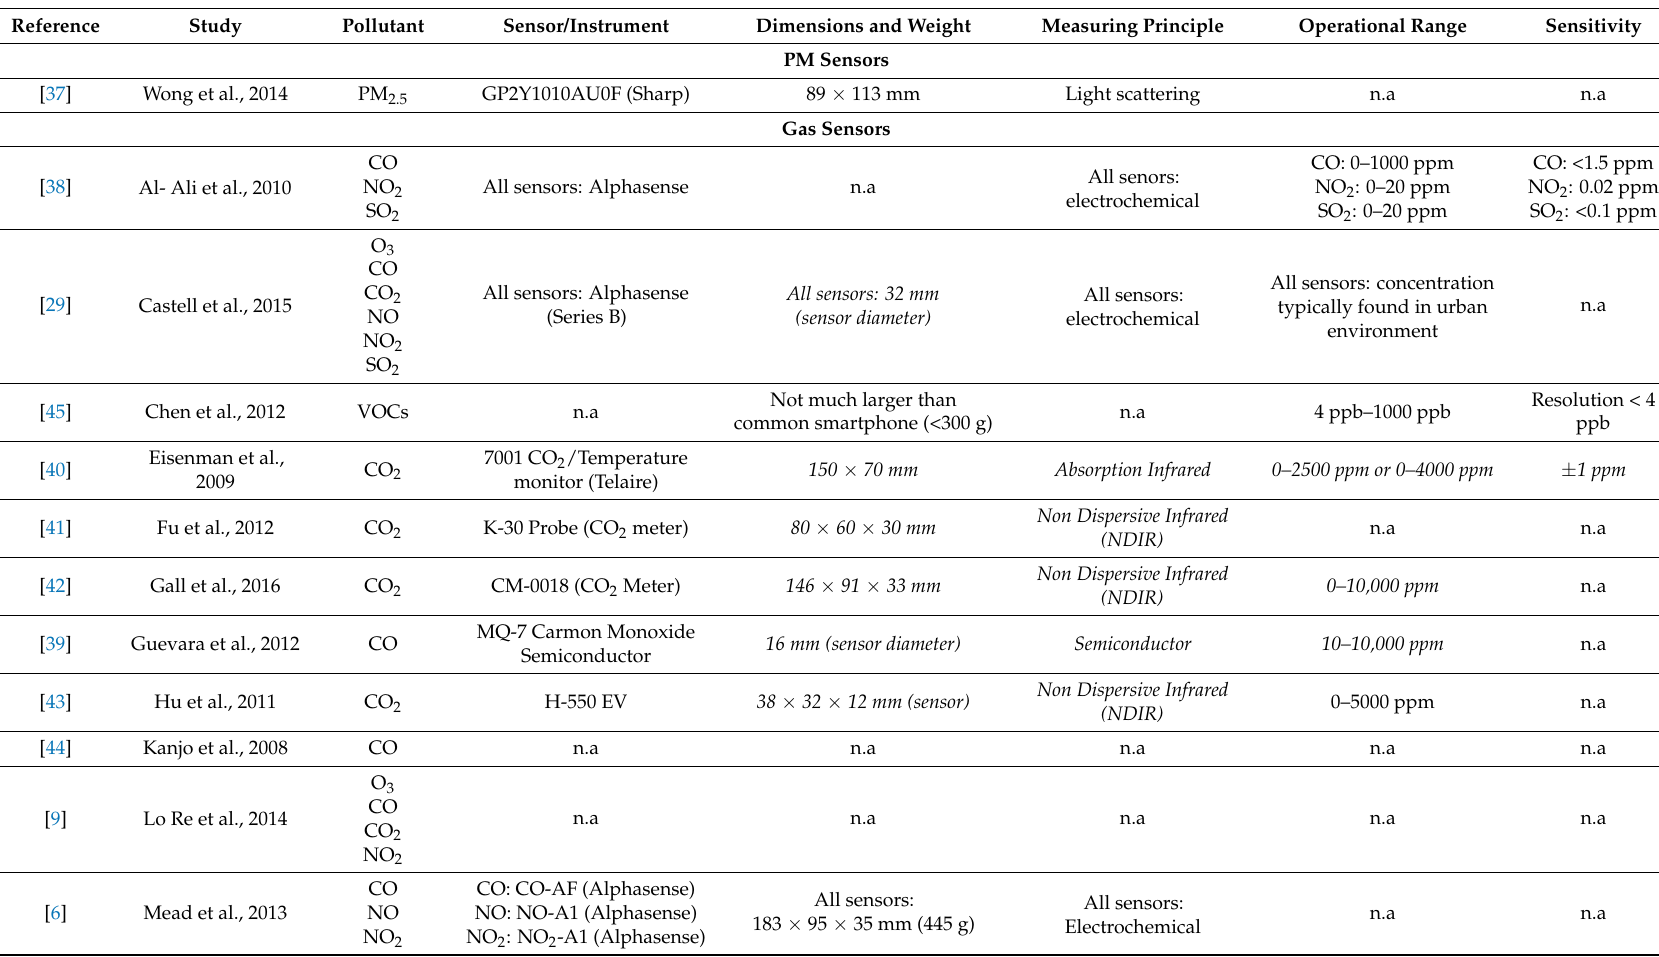
Table 3. Particulate and gas sensor characteristics as reported in the selected papers. Data that were not directly acquired from the paper are reported in italics. In the case of missing data within the reference papers, data were acquired from the literature cited in bibliography or from external sources (retailer’s